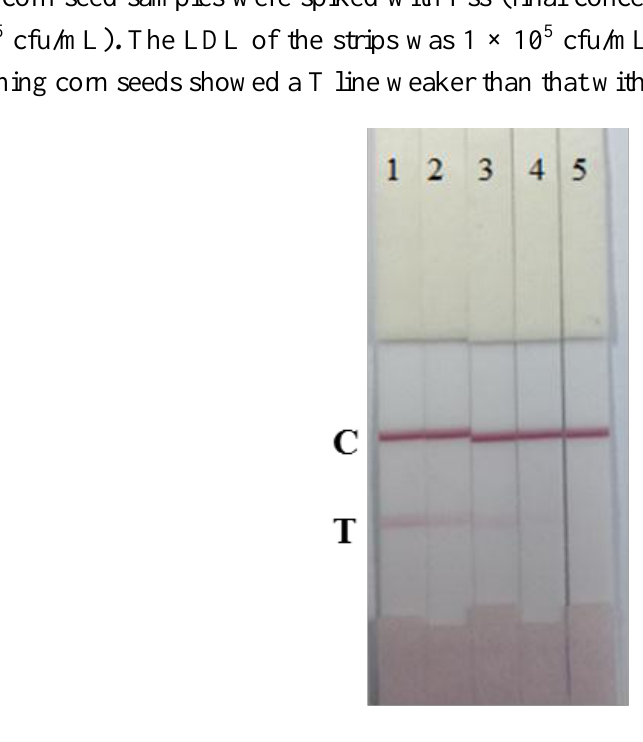
Figure 6. Detection of Pss-spiked corn seed samples by immunochromatographic strip. The concentration was as follows: (1) 1 × 10 7 , (2) 3.3 × 10 6 , (3) 1 × 10 6 , (4) 1 × 10 5 cfu/mL and (5) blank. T, test line. C, control